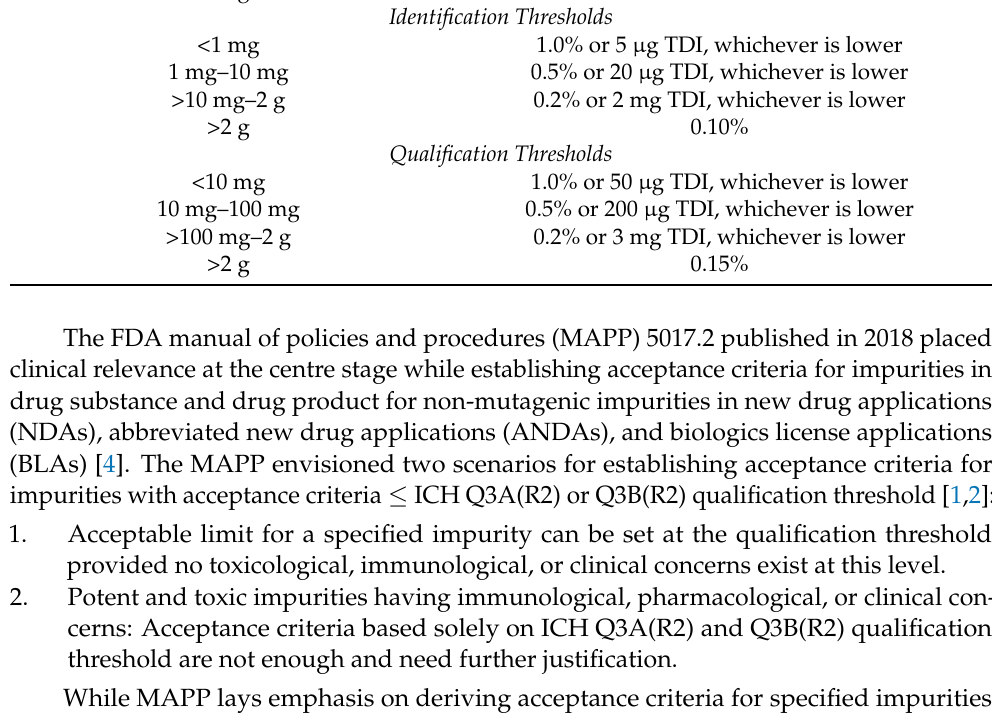
Table 1. Thresholds for impurities (degradation products) in new drug products. Maximum Daily Dose (Amount of Drug Substance Administered per Day)